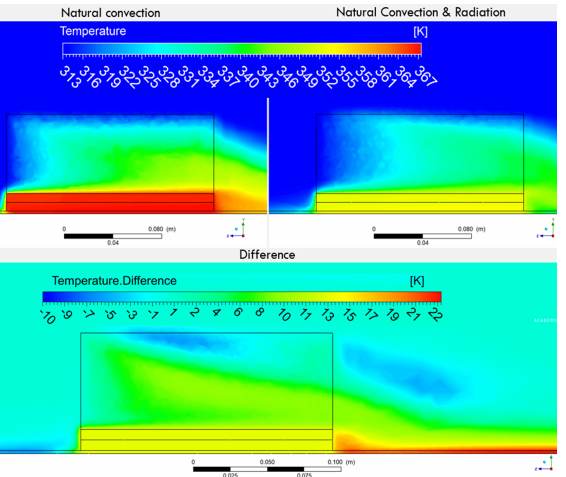
Figure 15. Temperature distribution and the difference between simulation assuming convection and both convection and